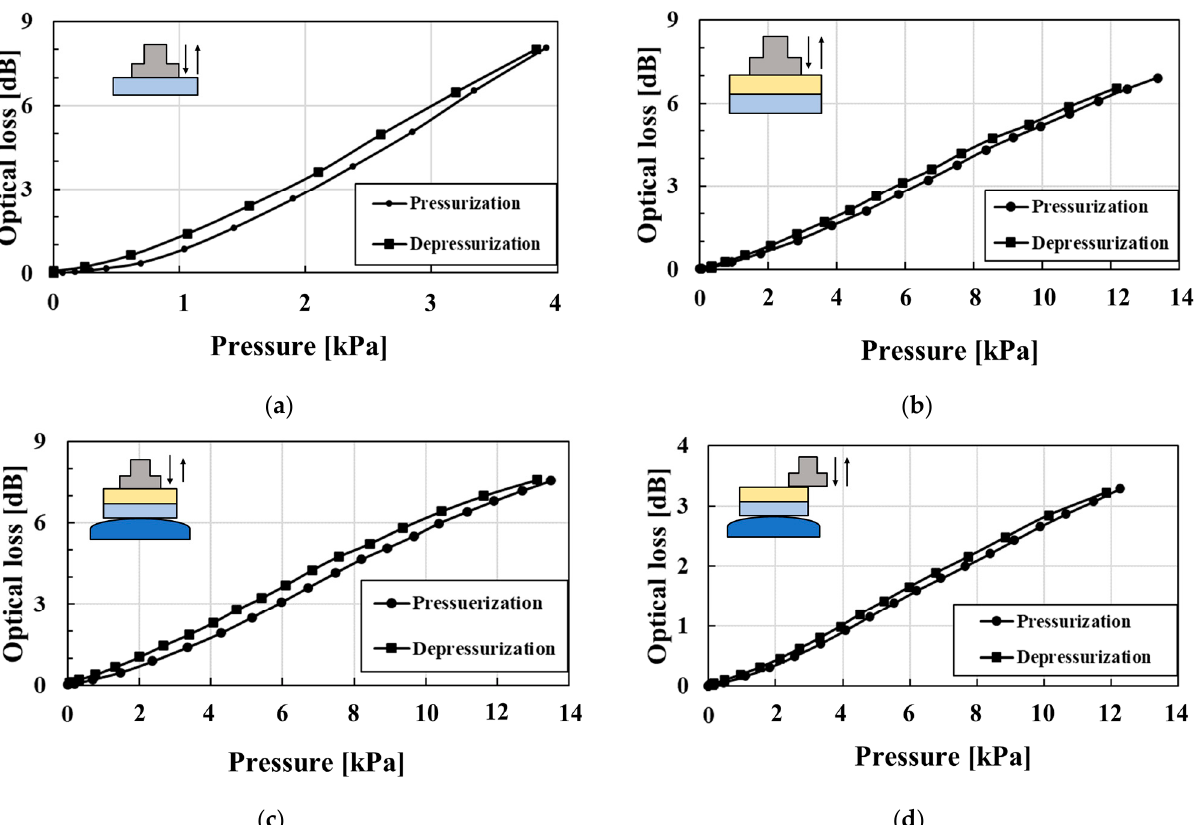
Figure 5. Characteristics of the hetero-core fiber-optic pressure sensor: ( a ) without the puff and the supporting part; ( b ) with the puff; ( c ) with the puff and the supporting part pressurized on the center; ( d ) with a puff and a supporting part pressurized on edge. Table 1. Sensitivities and R-square values of the sensor under each condition.